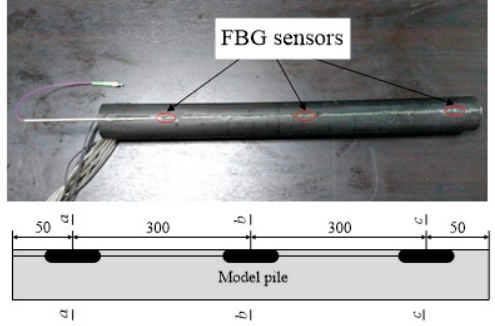
Figure 4. Photograph after encapsulating the FBG sensors and position of the FBG sensors in the